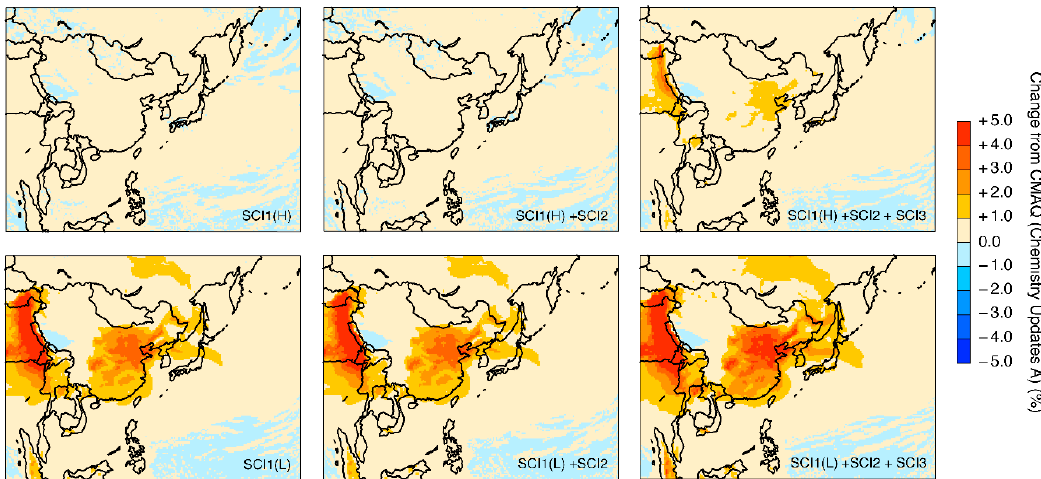
Figure 2. Spatial distribution of SO 42– concentrations simulated by the CMAQ chemistry updates B as changes from chemistry updates A averaged over the period 15–25 December 2016 in domain 1. The inclusion of SCI was tested incrementally as ( top-left ) only SCI1 with a higher rate constant for H 2 O (SCI1(H)), ( top-center ) the addition of SCI2 to SCI1(H), and ( top-right ) the addition of SCI3 to SCI1(H) and SCI2, ( bottom-left ) SCI1 with a lower rate constant of H 2 O (SCI1(L)), ( bottom-center ) the addition of SCI2 to SCI1(L), and ( bottom-right ) the addition of SCI3 to SCI(L) and SCI2.